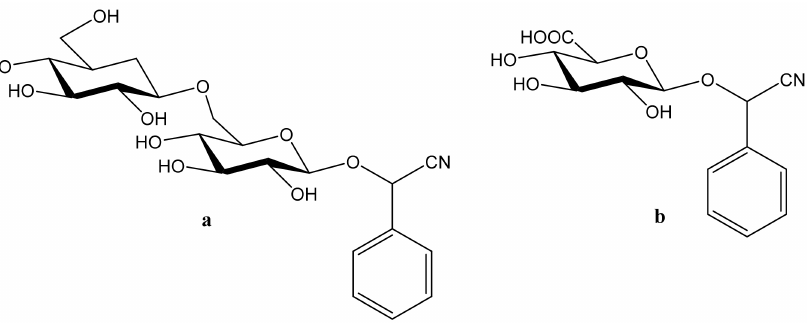
Figure 1. Chemical structures of amygdalin ( a ) and Laetrile ( b ).